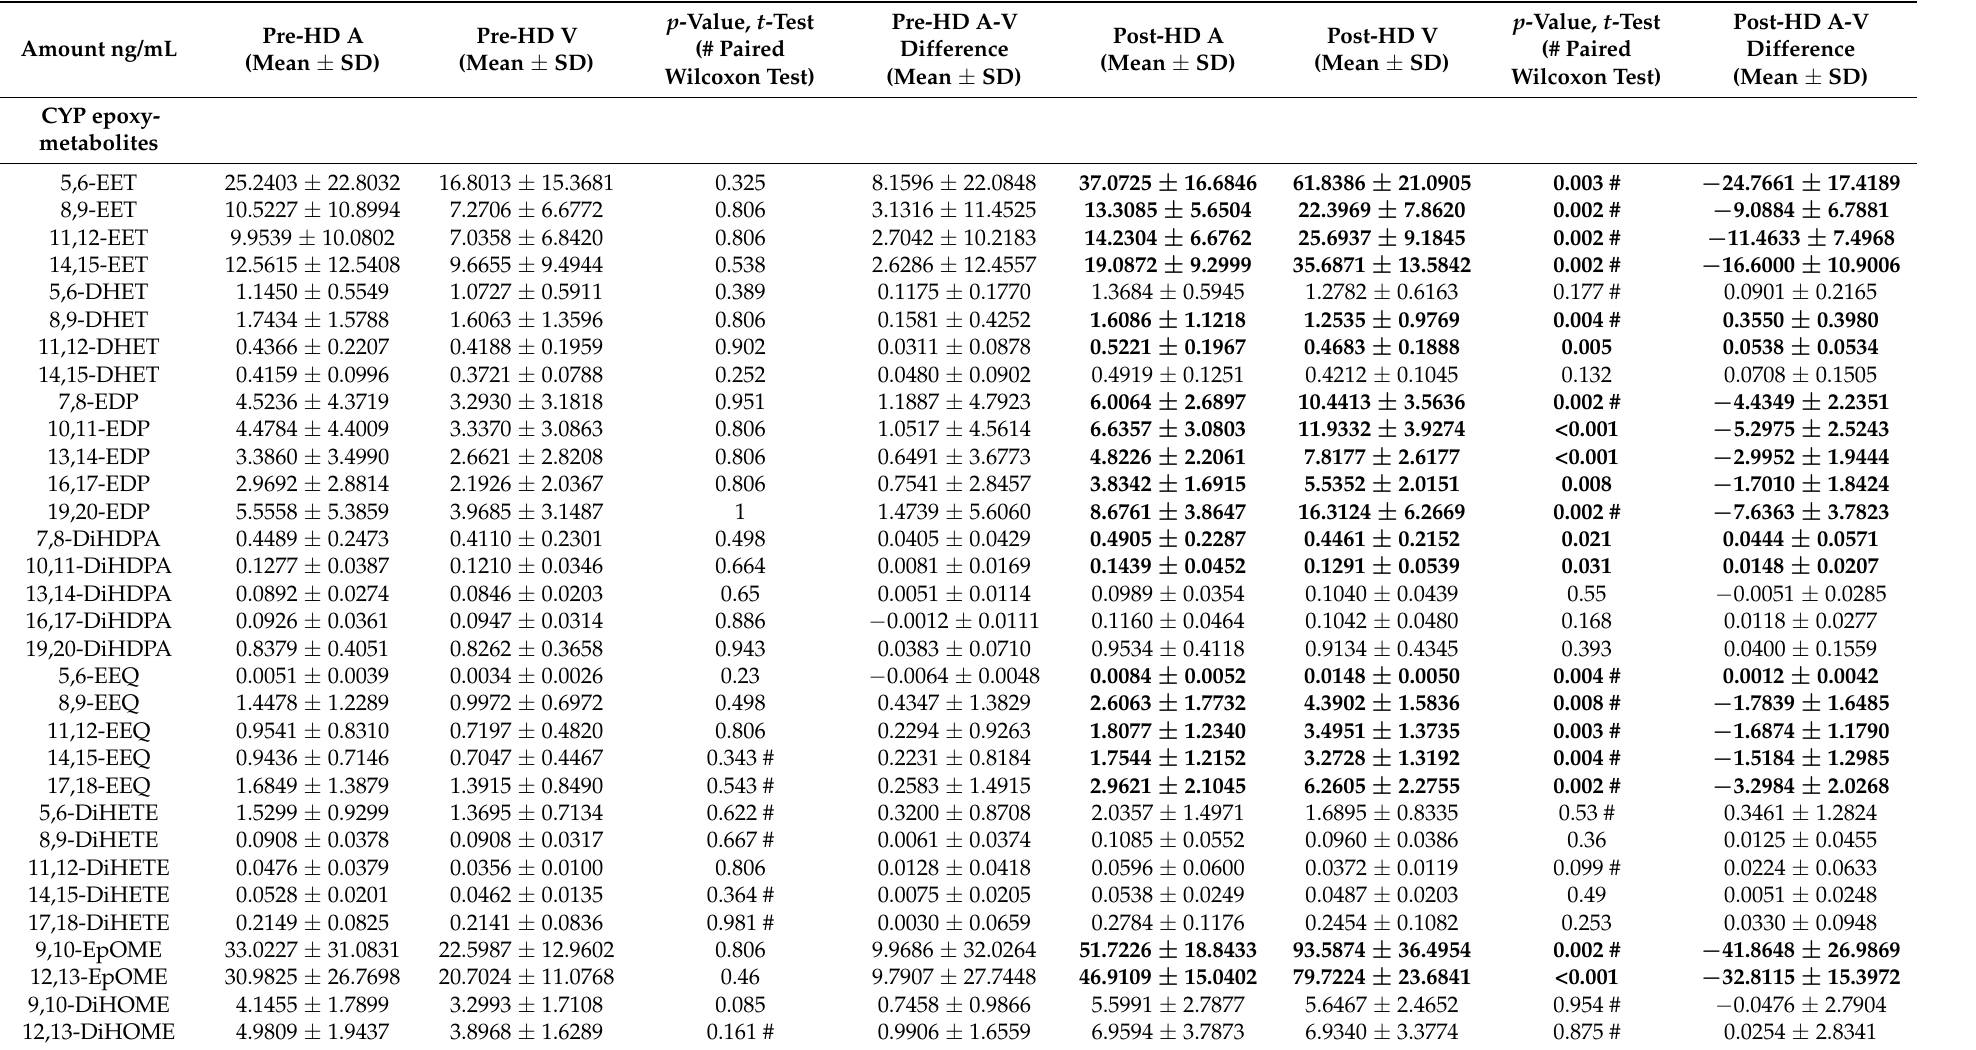
Table 2. Effects of hemodialysis on total oxylipins in the CKD patients before (pre-HD) and at cessation (post-HD) of hemodialysis ( n = 12